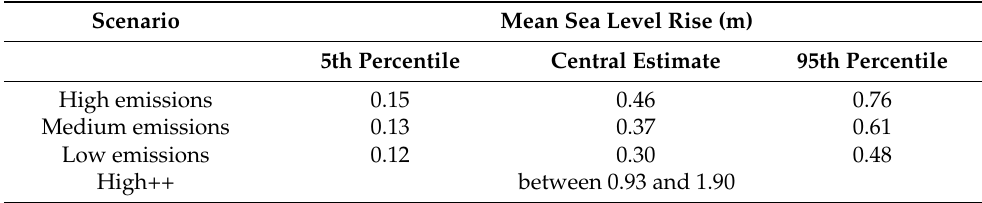
Table 2. UKCIP sea level rise projections averaged over the UK (1980–1999 and 2090–2099), after [7]. Scenario Mean Sea Level Rise (m) 5th Percentile Central Estimate 95th Percentile High emissions 0.15 0.46 0.76 Medium emissions 0.13 0.37 0.61 Low emissions 0.12